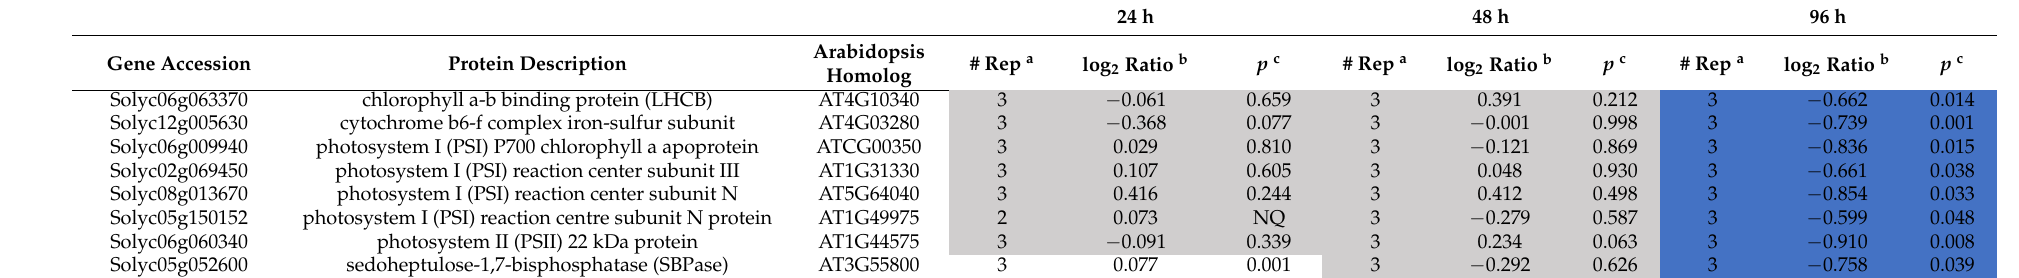
Table 6. Proteins involved in carbon fixation with a significant change in abundance at 24, 48 and 96 h post-inoculation with P. infestans .